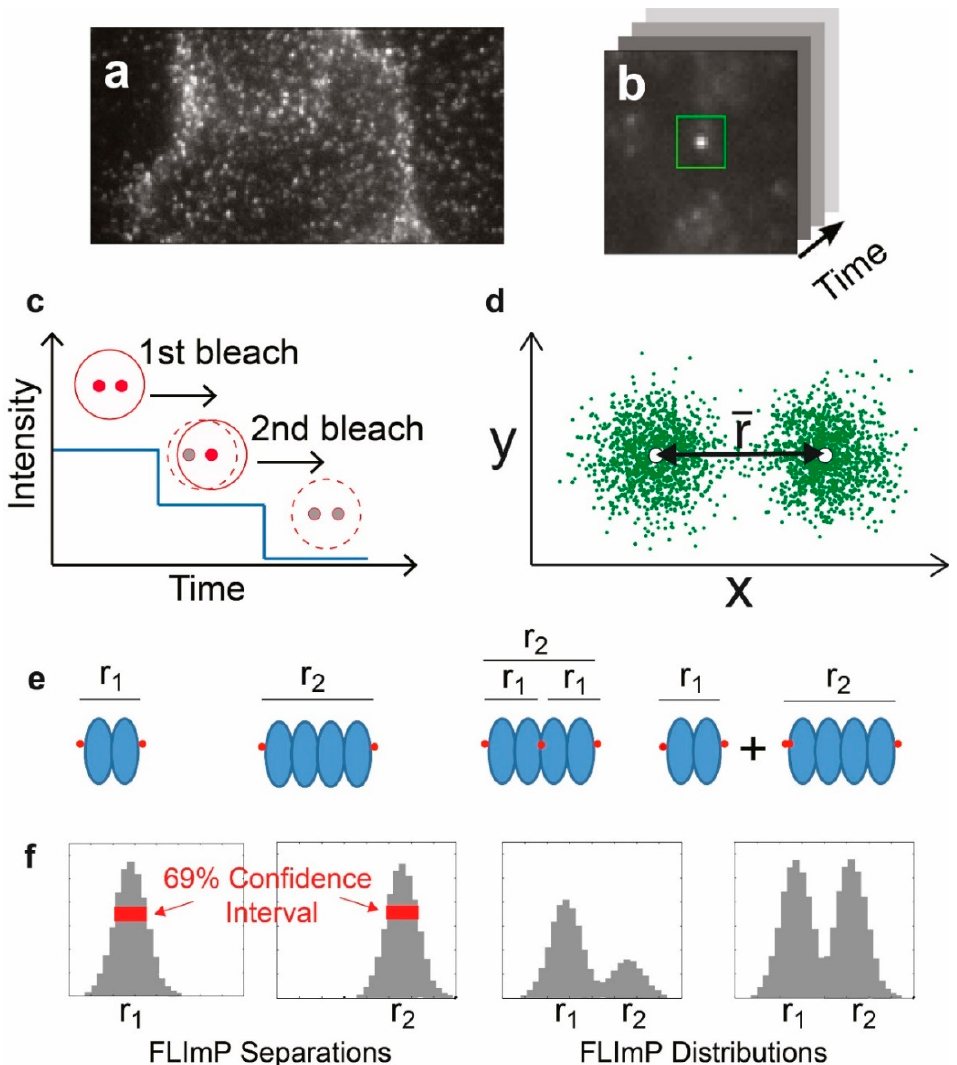
Figure 5. Determination of molecular separations using fluorophore localization imaging with photobleaching (FLImP). ( a ) A total internal reflection fluorescence (TIRF) microscope is used to collect single-molecule images from cells, and fluorescence intensity is measured vs. time for spots from individual complexes ( b ). ( c ) The fluorescence intensity of a spot containing two fluorophores decays in two photobleaching steps, with the centroid position shifting when one fluorophore bleaches. ( d ) The best intensity, x – y positions, and the full-width at half-maximum of the point spread function for each fluorophore are obtained using a global least squares seven-parameter fit. The fluorophore separation ( 𝒓 = (cid:3493)(𝒙 𝟏 − 𝒙 𝟐 ) 𝟐 + (𝒚 𝟏 − 𝒚 𝟐 ) 𝟐 ) is calculated from the fit, with the precision being determined by the localization error. ( e ) Examples of FLImP distributions that might be measured in EGF (red) bound to EGFR, showing a two-ligand dimer and tetramer, a three-ligand tetramer, and a dimer/tetramer mixture. ( f ) Simulations of empirical posterior distributions (or FLImP measurements) for pairwise ligand separations from each example system. Confidence intervals of 69% are highlighted. Figure adapted from Needham et al. 2016 [39].